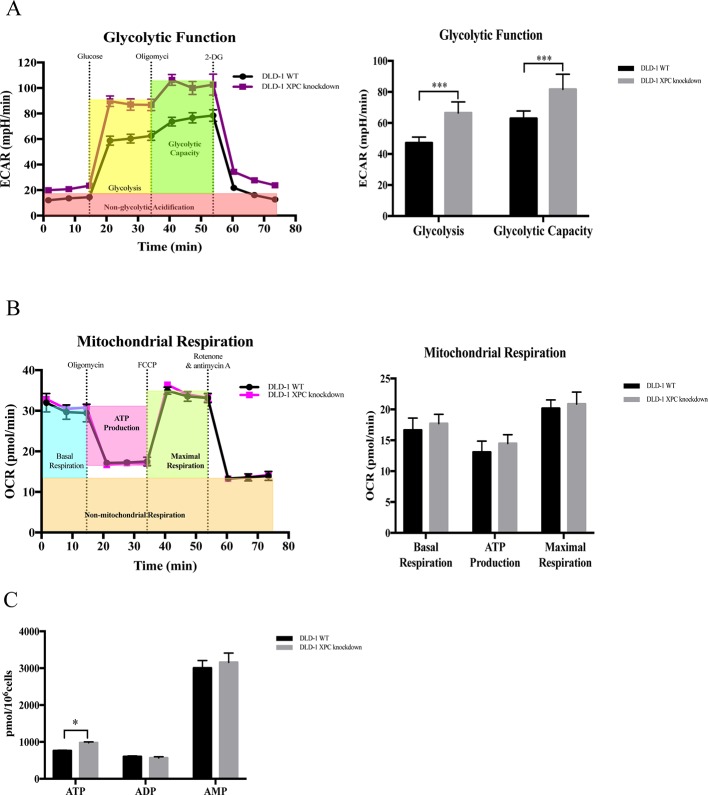
Capacity of glycolytic and mitochondrial respiration in DLD-1 WT cells and DLD-1 siXPC cells. (A) The glycolytic profile of DLD-1 WT and DLD-1 siXPC cells. (B) The mitochondrial respiration profile of DLD-1 WT and DLD-1 siXPC cells. (C) ATP production (pmol/106 cells) in DLD-1 WT and DLD-1 siXPC cells. The data is represented as mean ± S.D. (n = 3). ***p < 0.001 and *p < 0.05 compared with DLD-1 WT cells, t-tests analysis.